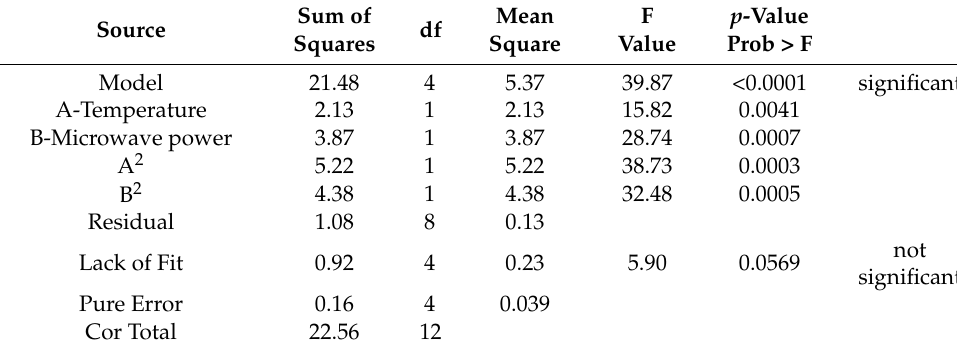
Table 11. Analysis of variance for TPC response using